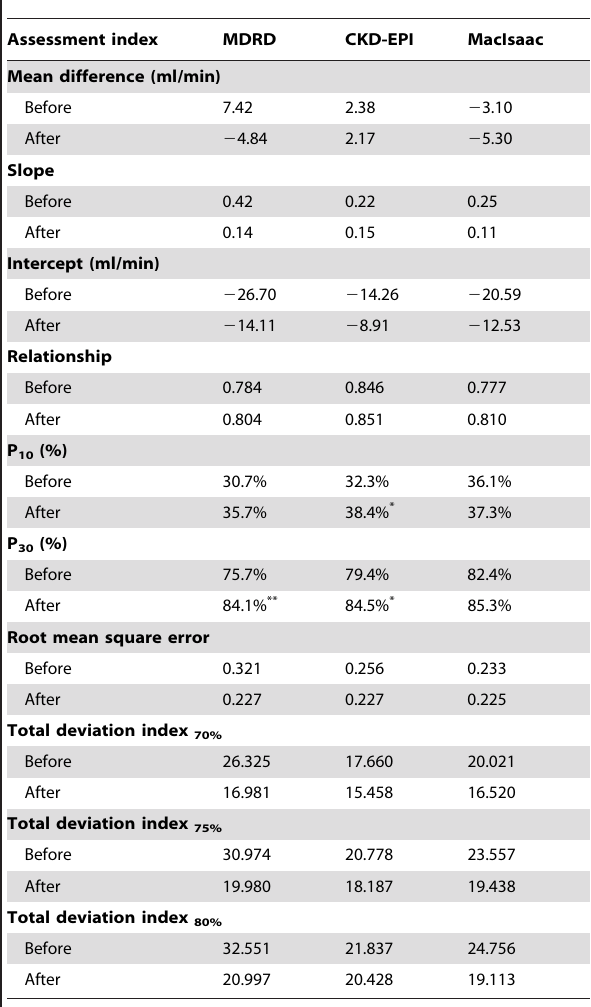
Table 4. Comparison of performance of glomerular filtration rate equations before and after modification in the validation